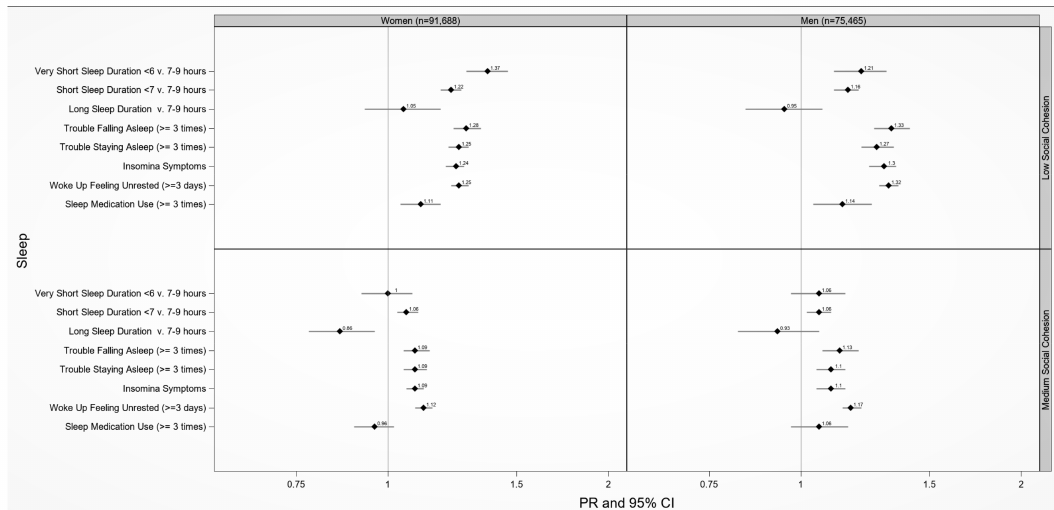
Figure 2. Adjusted prevalence ratios of sleep health by low and medium compared to high neighborhood social cohesion among U.S. women and men, National Health Interview Survey, 2013–2018 (N = 167,153). Sex / gender specific models adjusted for age (18–30, 31–49, 50 + years), race / ethnicity (NH-White, NH-Black, Hispanic, and Asian), educational attainment ( < high school, high school graduate, some college, ≥ college), annual household income ( < $35,000, $35,000–$74,999, $75,000 + ), occupational class (professional / management, support services, laborers), region of residence (Northeast, Midwest, South, West), alcohol consumption (never, former, current), serious mental illness (Kessler-6 psychological distress scale score ≥ 13), “ideal” cardiovascular health (never smoking / quit > 12 months prior to interview, BMI 18.5 to < 25 kg / m 2 , meeting physical activity guidelines, and no prior diagnosis of dyslipidemia, hypertension, or diabetes / prediabetes), marital / co-habiting status (married / living with partner or cohabitating, divorced / widowed / separated, single / no live-in partner), employment status (unemployed, employed), and health status (excellent / very good, good, fair / poor). Reference level: high neighborhood cohesion. Note. All estimates are weighted for the survey’s complex sampling design. Insomnia symptoms defined as either trouble falling asleep and / or di ffi culty maintaining sleep 3 + times a